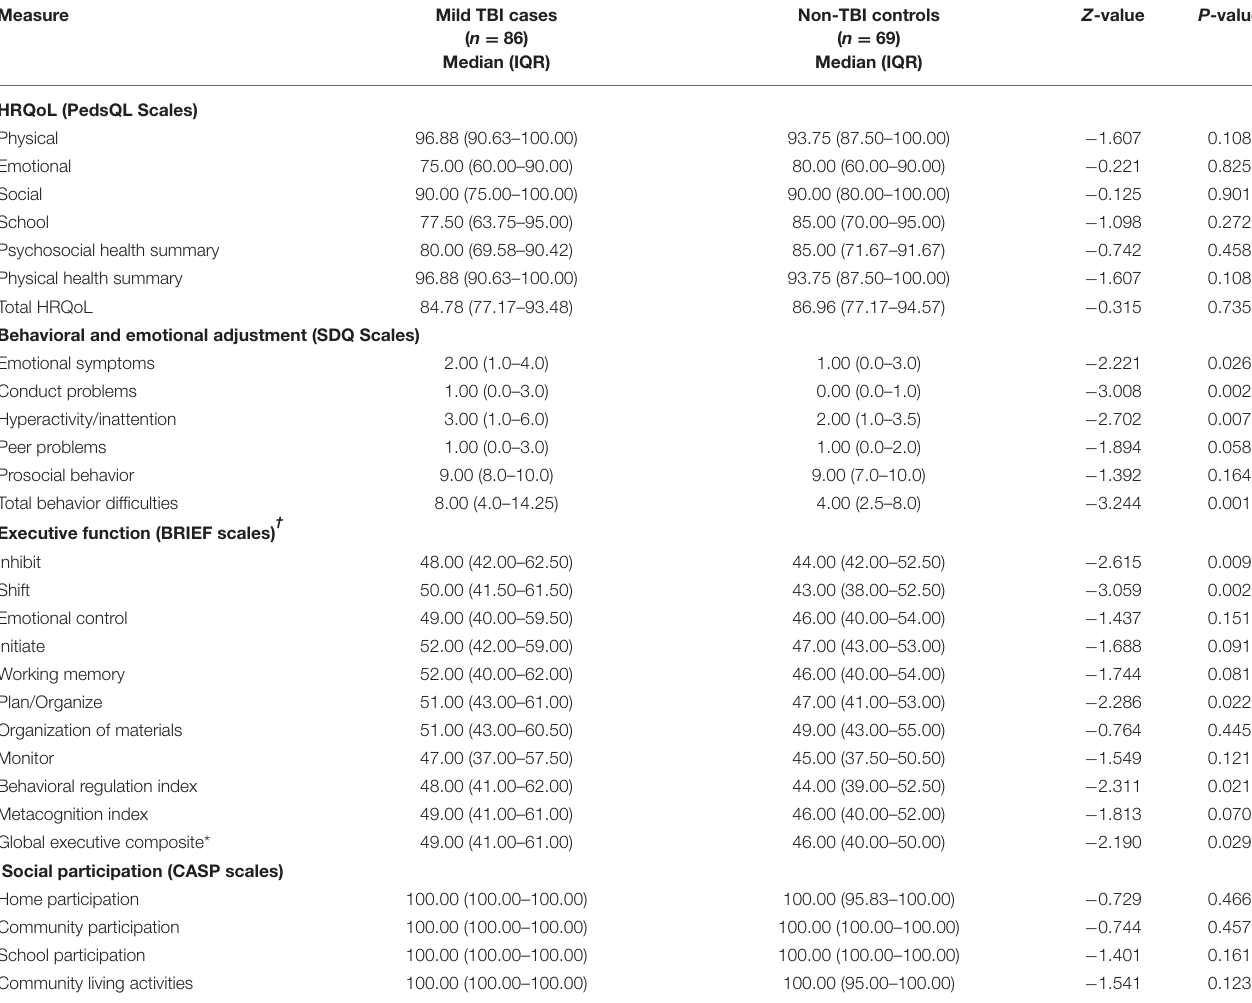
TABLE 2 | Parent-reported child outcomes for mild TBI cases and non-TBI controls (Aim 1).